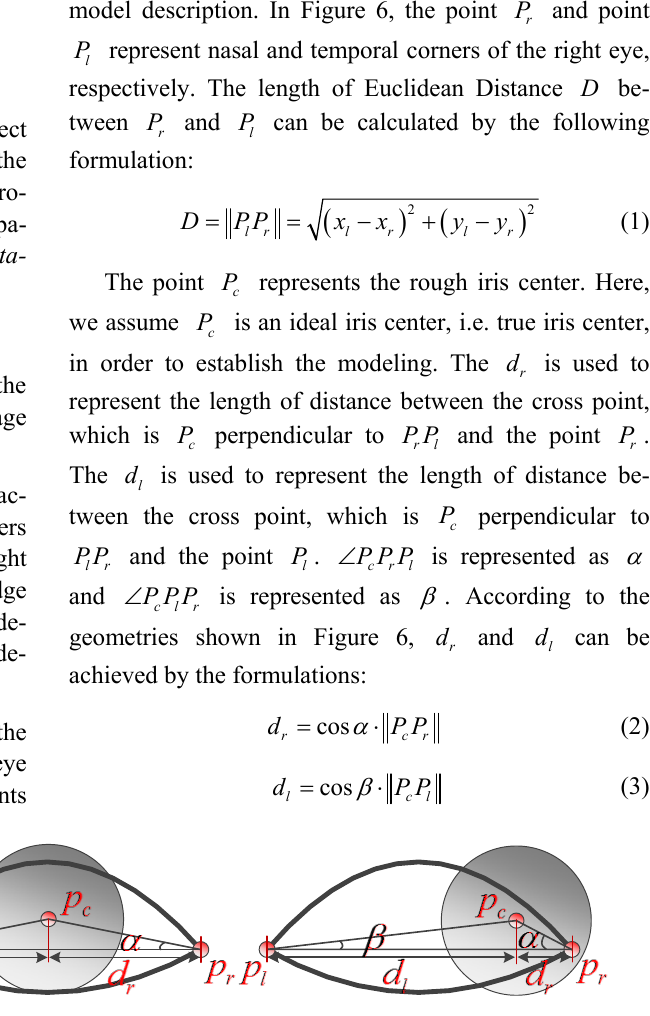
Figure 6: Three states of iris within eye region and geometrical relationship between the eye corners and the ideal iris centre.